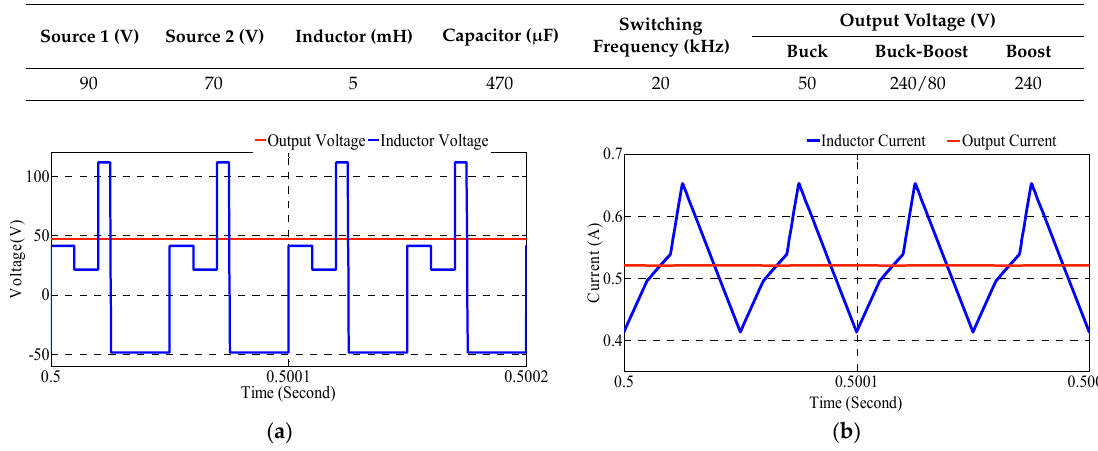
Table 3. Design parameters of the MBDC converter.